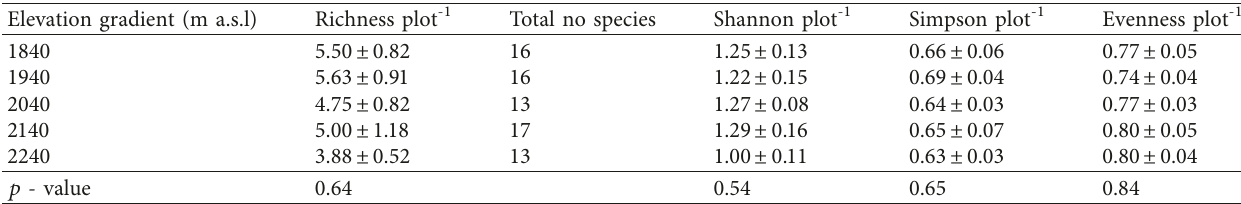
Table 2: Mean value of woody species richness, Shannon-Wiener index, evenness, and Simpson index along an elevation gradient of coffee- based agroforestry system. Elevation gradient (m a.s.l)